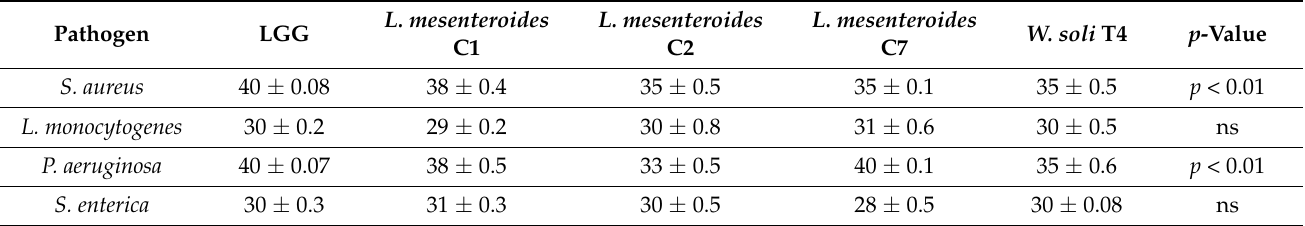
Table 3. Antagonistic activity in vitro. The diameter of inhibition halos was recorded in mm and the data were expressed as average ±